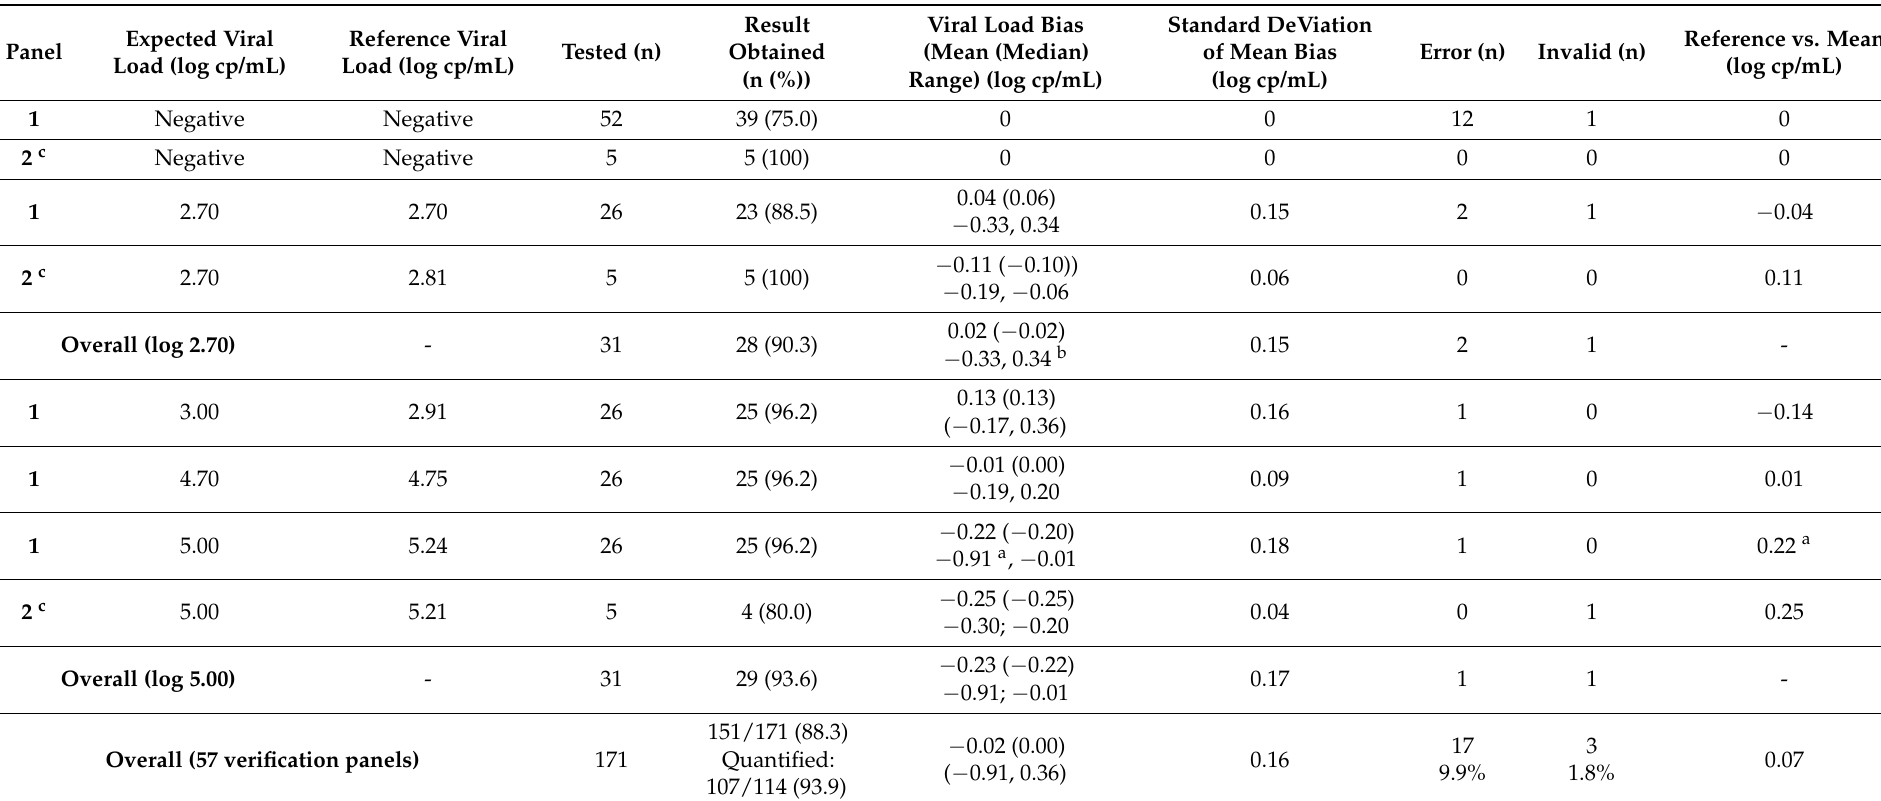
Table 2. Site Verification Summary: September 2017–November 2018 (compared to reference